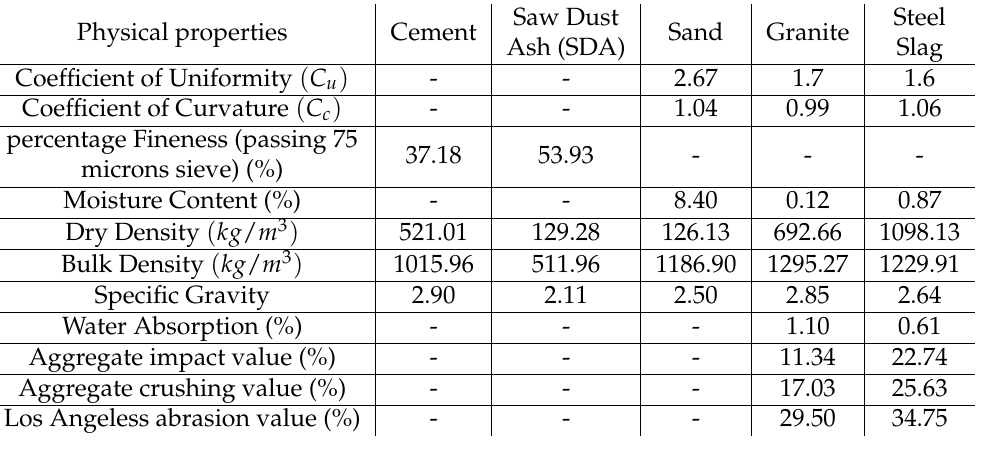
Table 3. Physical properties of studied